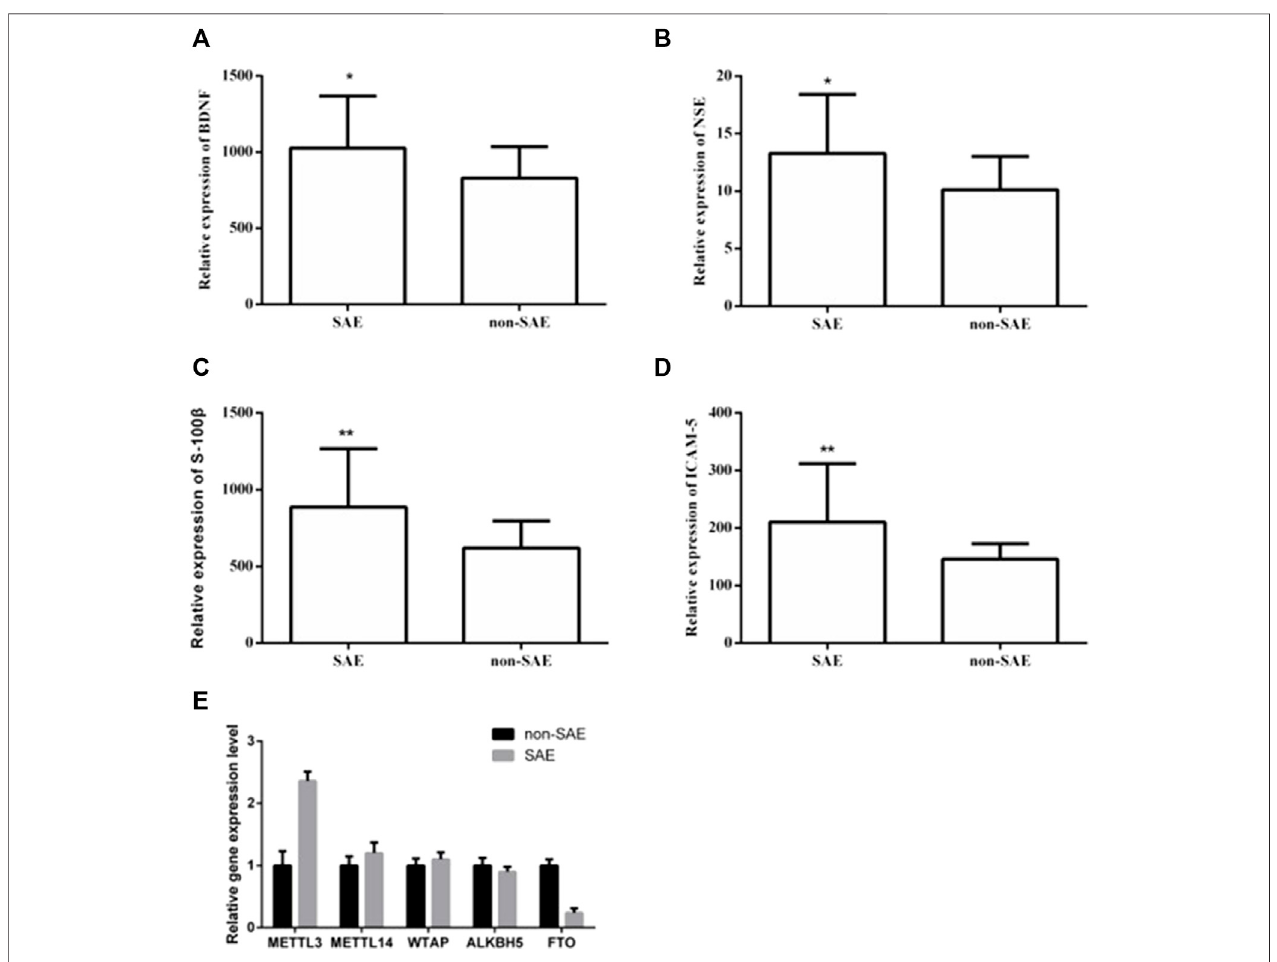
FIGURE 1 | The expression levels of BDNF, NSE, S-100 β , ICAM-5, METTL3 and FTO in blood. The expression levels of BDNF (A) , NSE (B) , S-100 β (C) , ICAM-5 (D) . * and ** indicates p < 0.05 and 0.01 respectively.